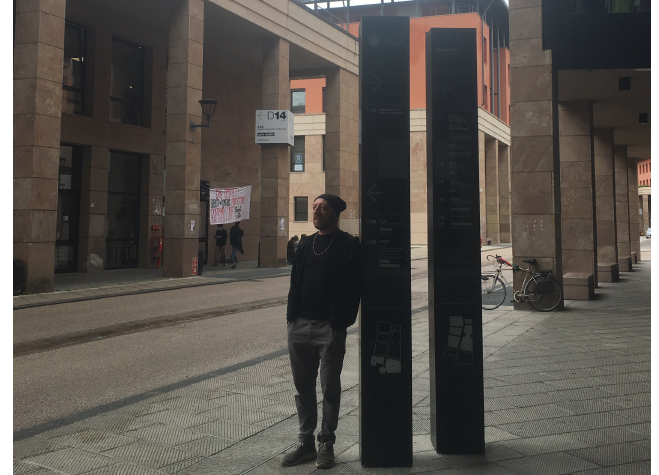
Fig. 6 F. Pipparelli is acting out a passage from The Giufà Project ,